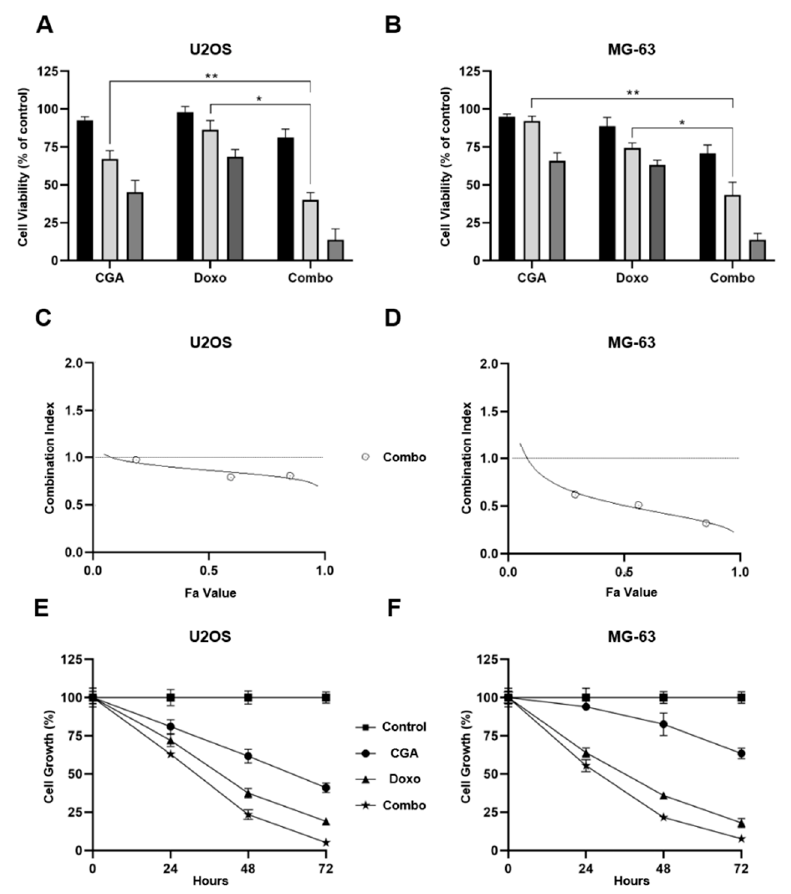
Figure 2. Assessment of CGA, Doxo, and CGA plus Doxo-mediated effects on cell viability and proliferation in OS cells. 100 µM (black bar), 200 µM (light-gray), and 400 µM (gray) of CGA and 0.05 µM (black bar), 0.1 µM (light-gray), and 0.2 µM (gray) of Doxo were administrated individually and together in U2OS ( A ) and MG-63 ( B ) for 48 h. Subsequently, cell viability was estimated by MTT assays and shown as mean ± SD in percentage of control. U2OS ( C ) and MG-63 ( D ) Fa-CI plots were determined employing CompuSyn software analysis. Representative reports are illustrated in figure. Growth curves at 24, 48, and 72 h were recorded in response to untreated (control), 200 µM CGA, 0.1 µM Doxo, and CGA plus Doxo (combo) in both U2OS ( E ) and MG-63 ( F ). Percentage growth values of three distinct biological replicates, expressed as average ± SD, are displayed. * p < 0.05, ** p < 0.01 by an unpaired two-tailed t -test.